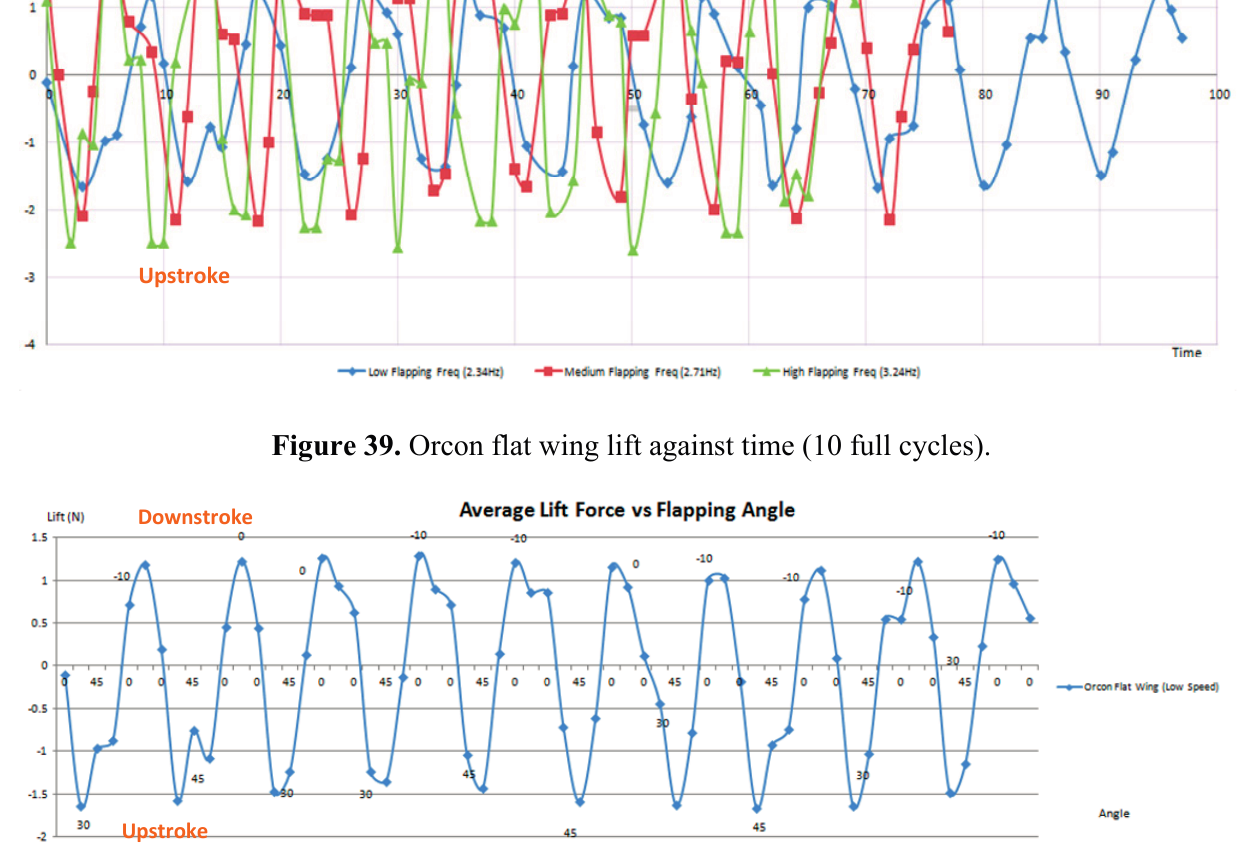
Figure 40. Average lift force vs . angle (Orcon flat